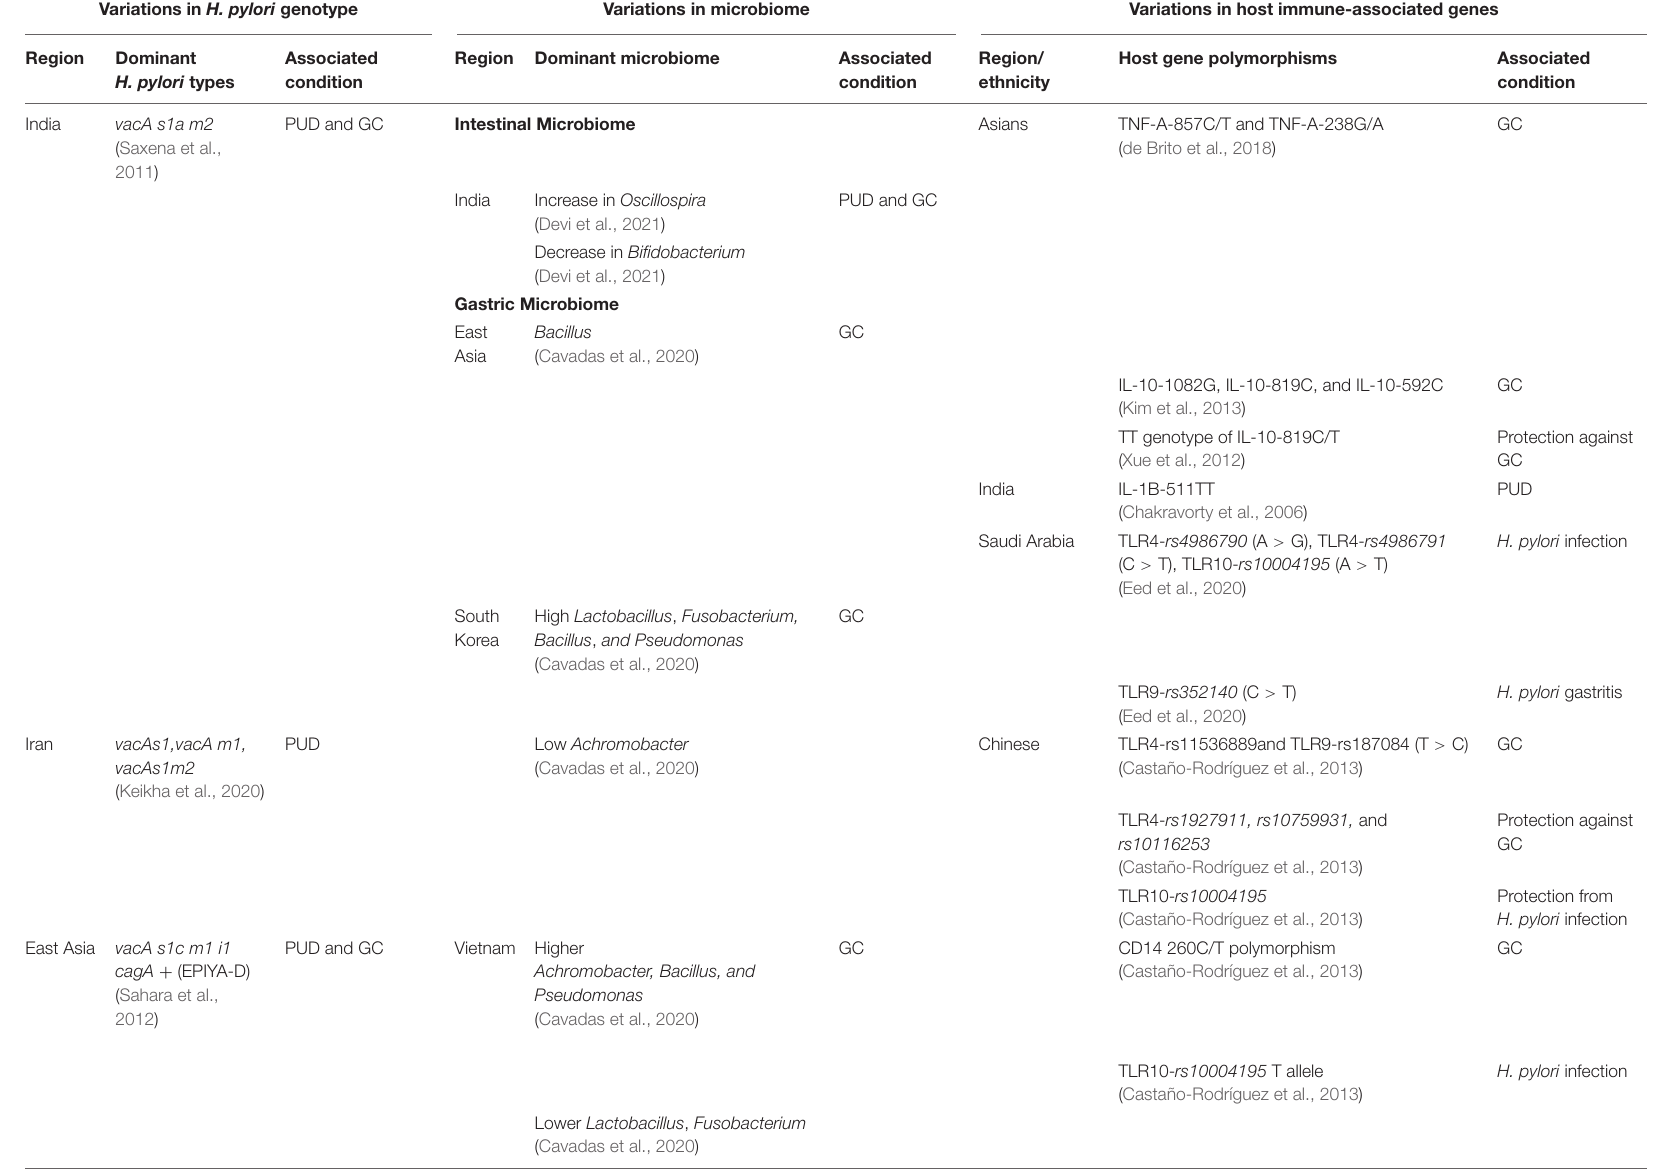
TABLE 1 | Variations in H. pylori genotype, microbiome, and host genes and association with gastric diseases. Variations in H. pylori genotype Variations in microbiome Variations in host immune-associated